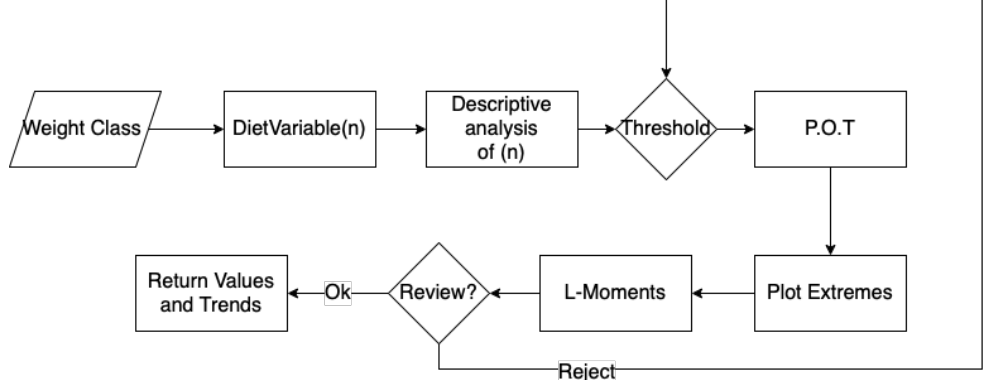
Figure 3. Dietary variable analysis and diet intervention